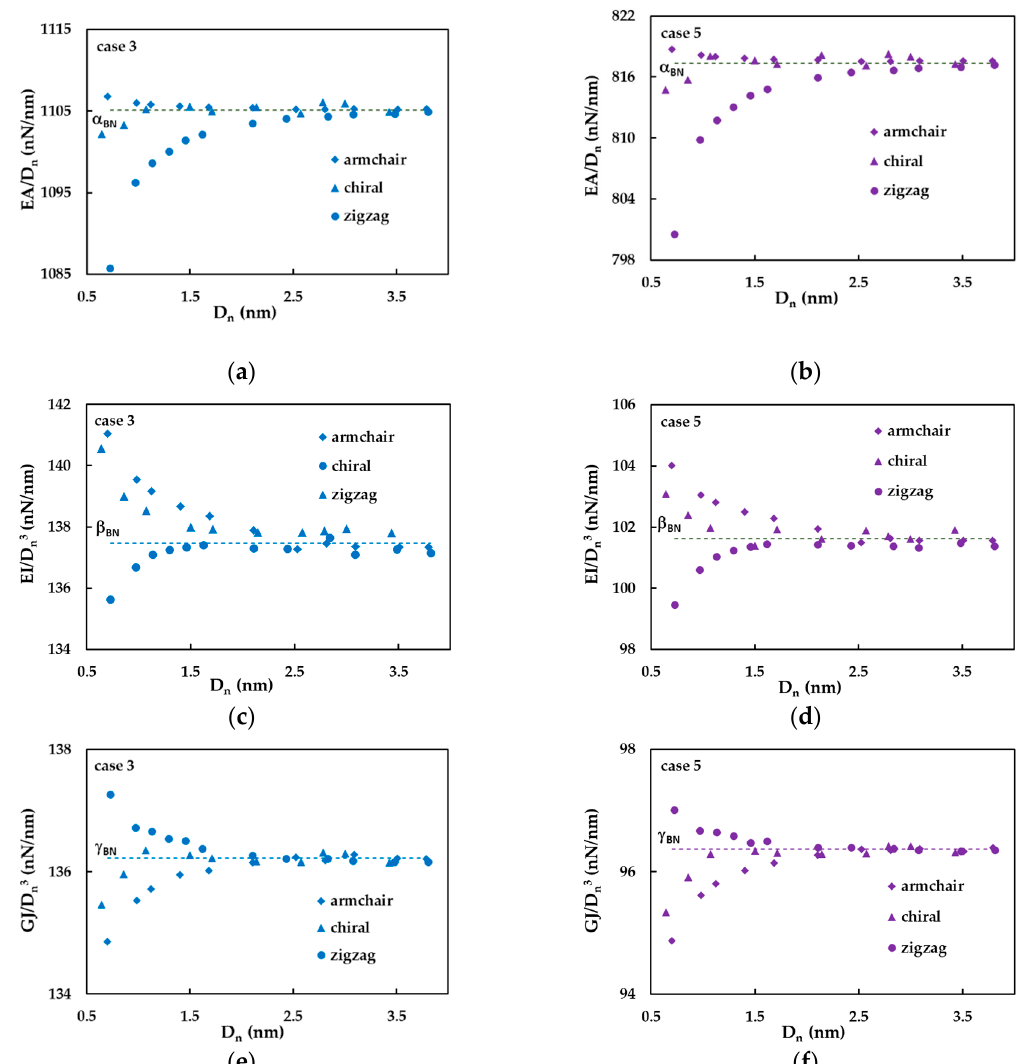
Figure 6. The evolutions of the ratios EA/D n ( a , b ), EI/D n3 ( c , d ) and GJ/D n3 ( e , f ) with the SWBNNT diameter, D n , for case 3 ( a , c , e ) and case 5 ( b , d , f ).